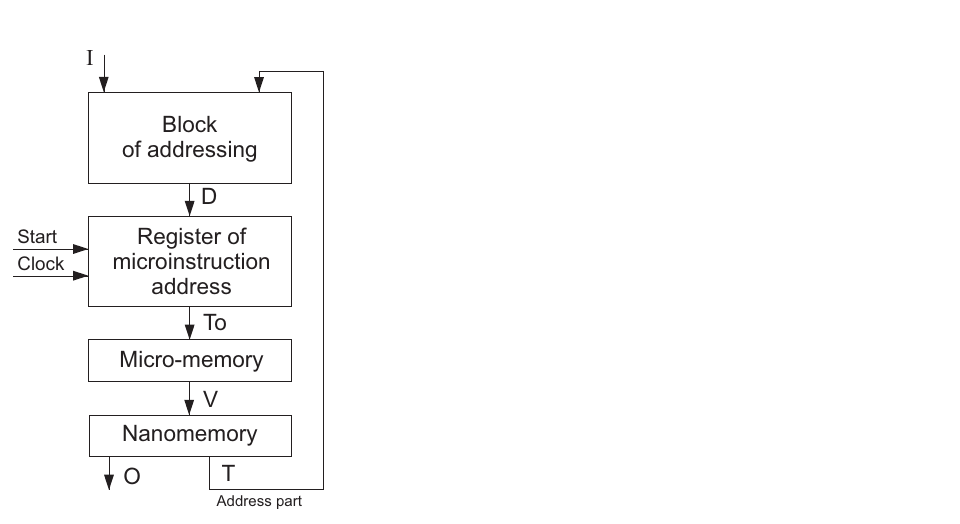
Figure 8. Organization of microprogram control unit (MCU) with nanomemory.